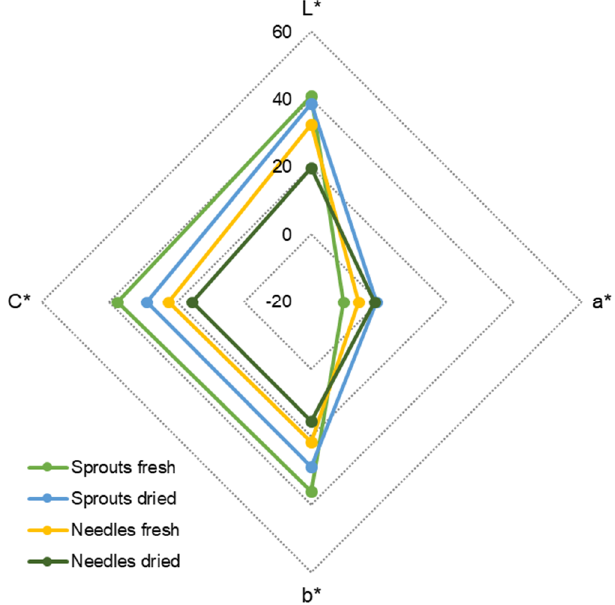
Figure 2. Quantitative color measurements of fresh and freeze-dried sprouts and needles of Norway spruce. L* indicates lightness, C* represents chroma, a* expresses color from green to red, and b* expresses color from blue to yellow.